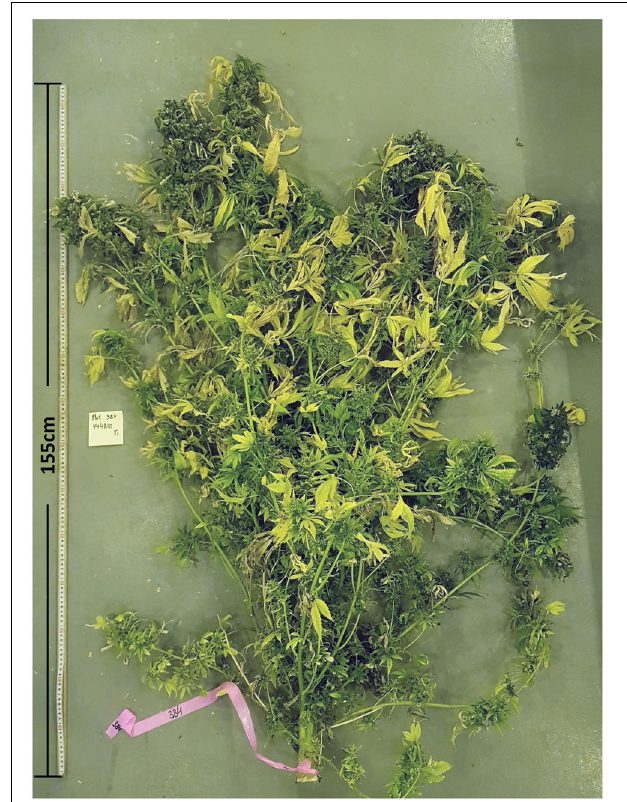
FIGURE 1 | A whole cannabis plant at the time of